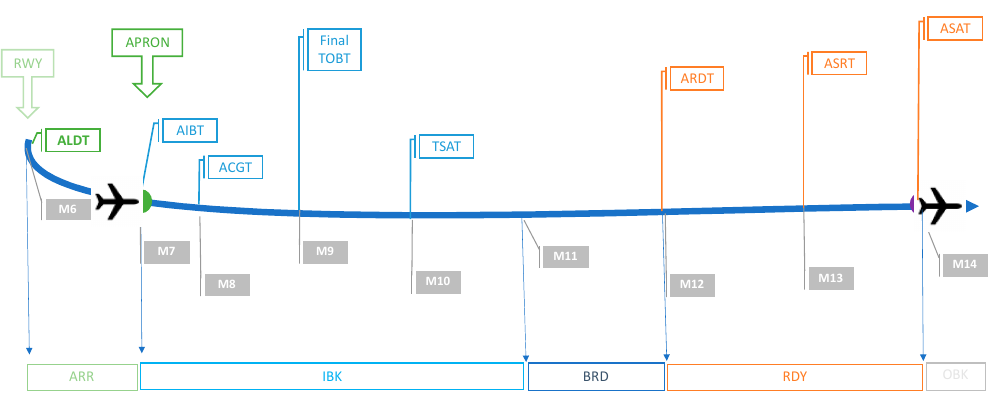
Figure 4. The turn-round phase of the flight on the milestone approach and its nomenclature.